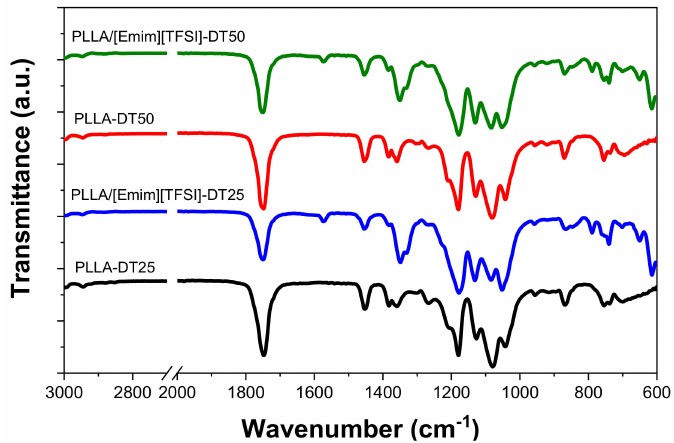
Figure 3. ATR / FTIR spectra of the PLLA and PLLA / [Emim][TFSI] films obtained at di ff erent drying temperatures. Table 1. Main absorption bands of PLLA and [Emim][TFSI] in the prepared samples.